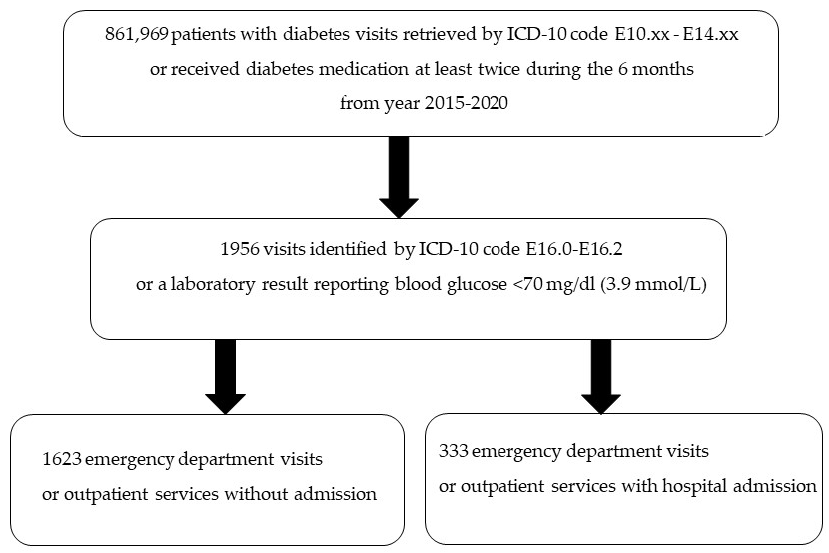
Figure 1. Patient selection fl ow chart.